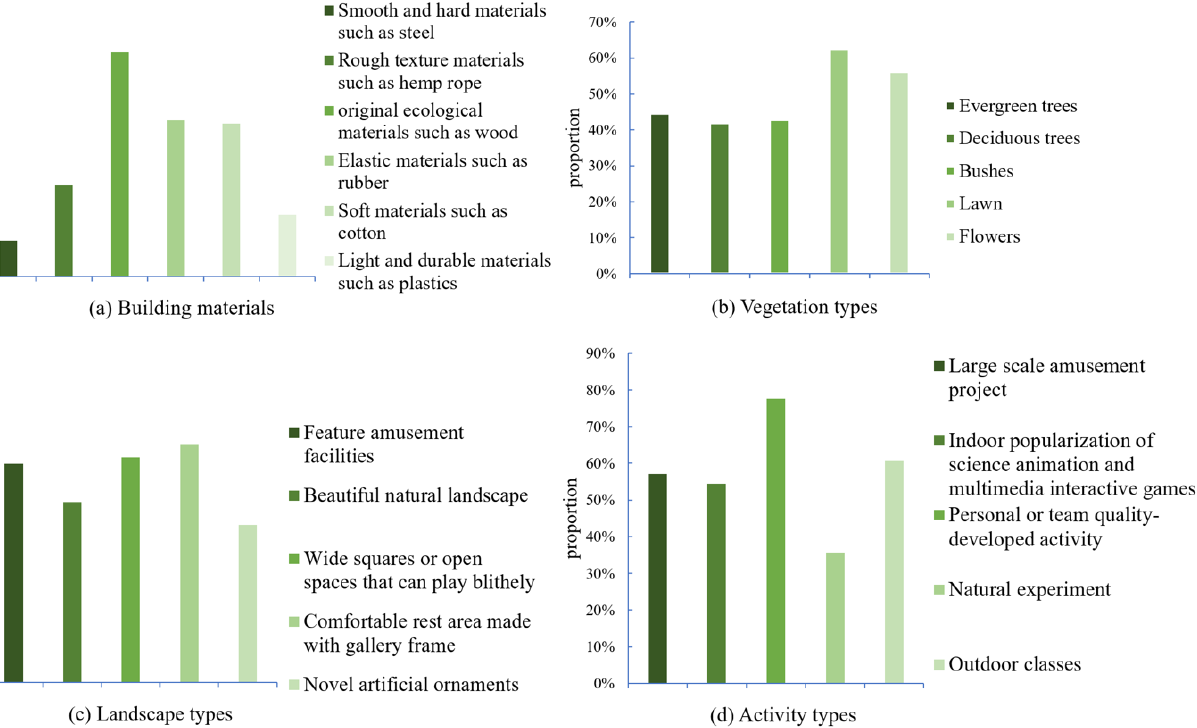
Figure 6. Children ’ s preference for children ’ s activity areas in urban forest parks. ( a ) Building materials; ( b ) vegetation types; ( c ) landscape types; and ( d ) activity types. All items were set as multiple-choice questions.